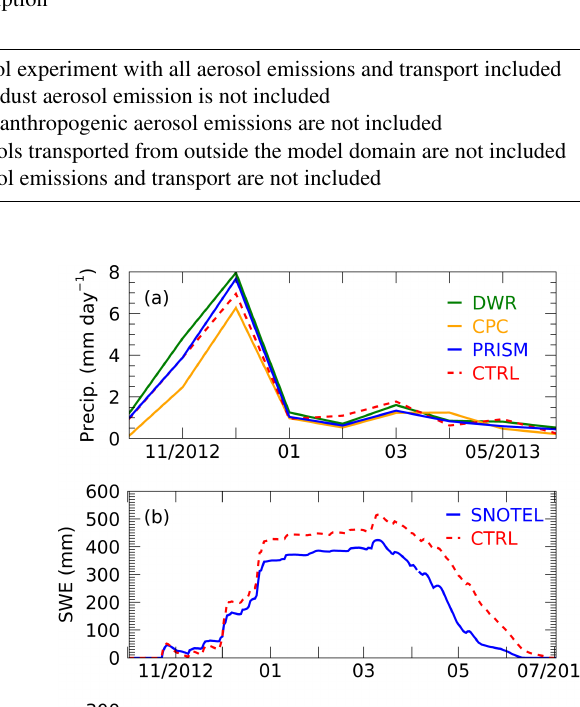
Table 2. Experimental design for various aerosol sources. Experiment